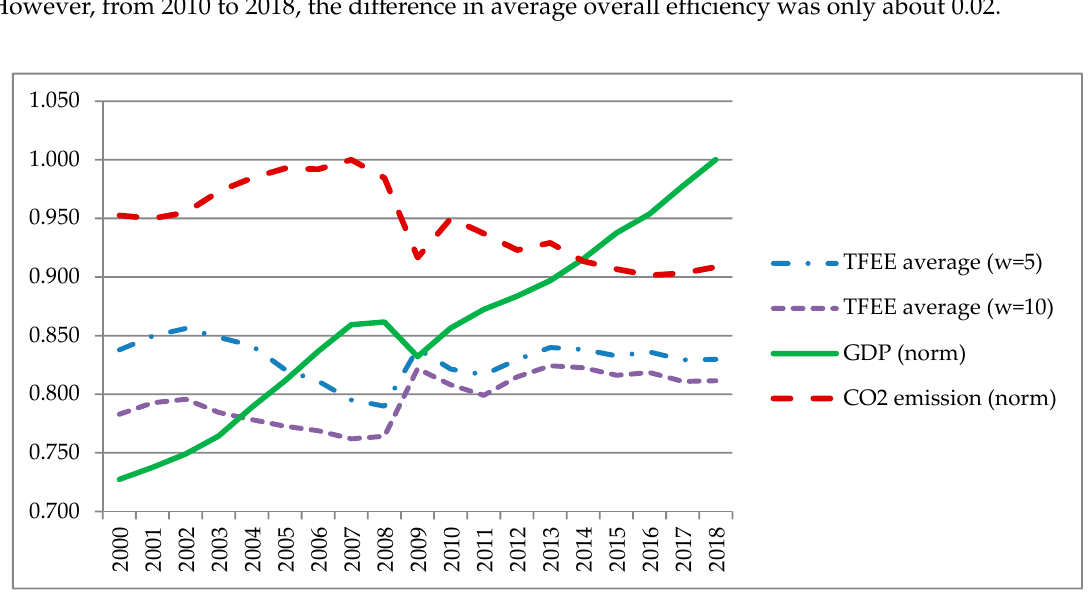
Table 4. Analytics of TFEE.